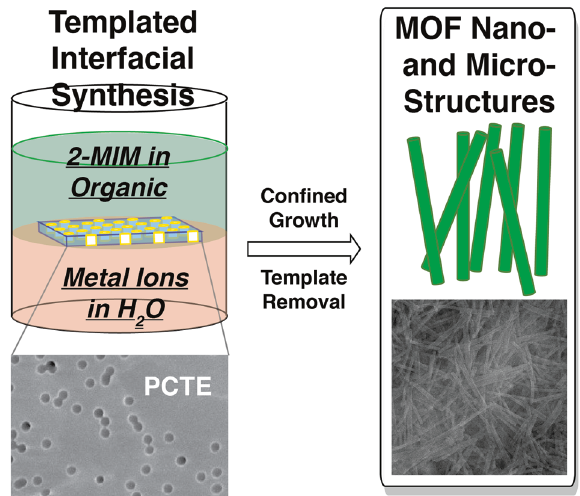
Fig. 1 Schematic illustration of the synthesis of ZIF-8 and ZIF-67 1-D nano- and micro-structures. PCET track-etched polycarbonate, 2-MIM 2- methylimidazole.